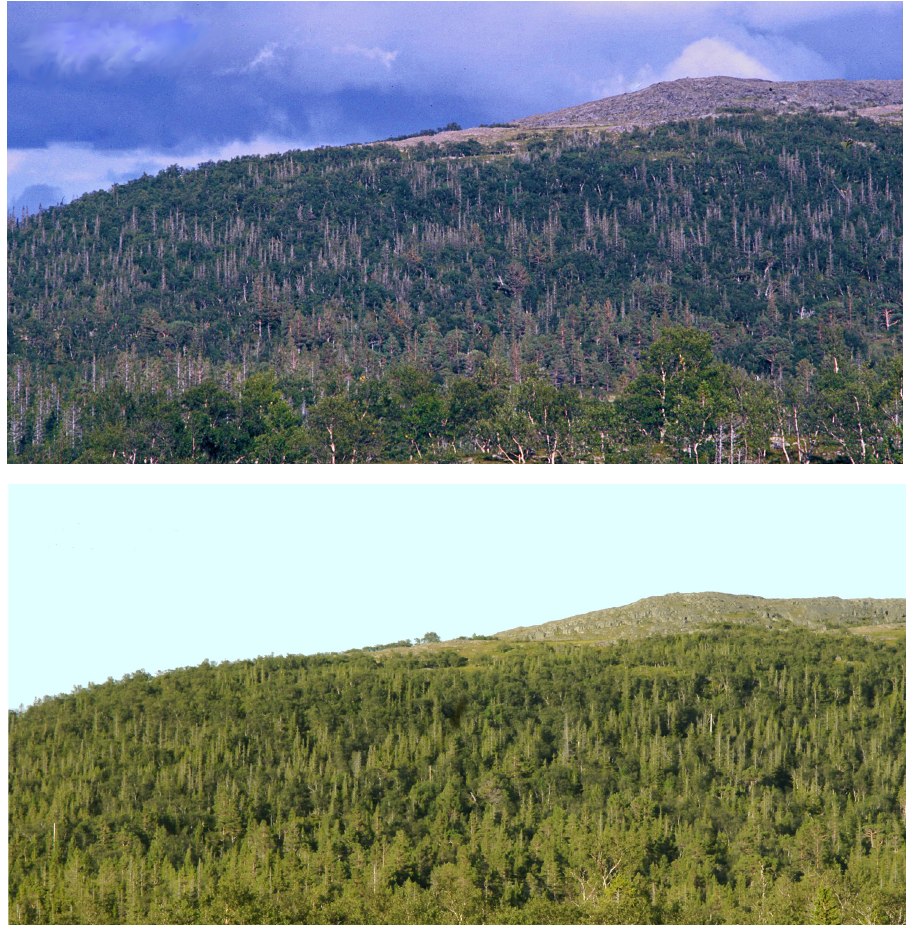
Figure 25: Upper. Episodic climate cooling during the 1980s conditioned landscape-scale defoliati- on of high-elevation spruce forests (grayish trees) in the southern Swedish Scandes. On this speci- fic slope, the majority of spruce trees lost more than 60 % of their needles (Kullman 1989). Lower. Du- ring the past decade a remarkable foliage recovery has changed the face of the entire landscape. Mt. Täljstensvalen (1989 and 2009). Both images were taken in the early evening with similar light